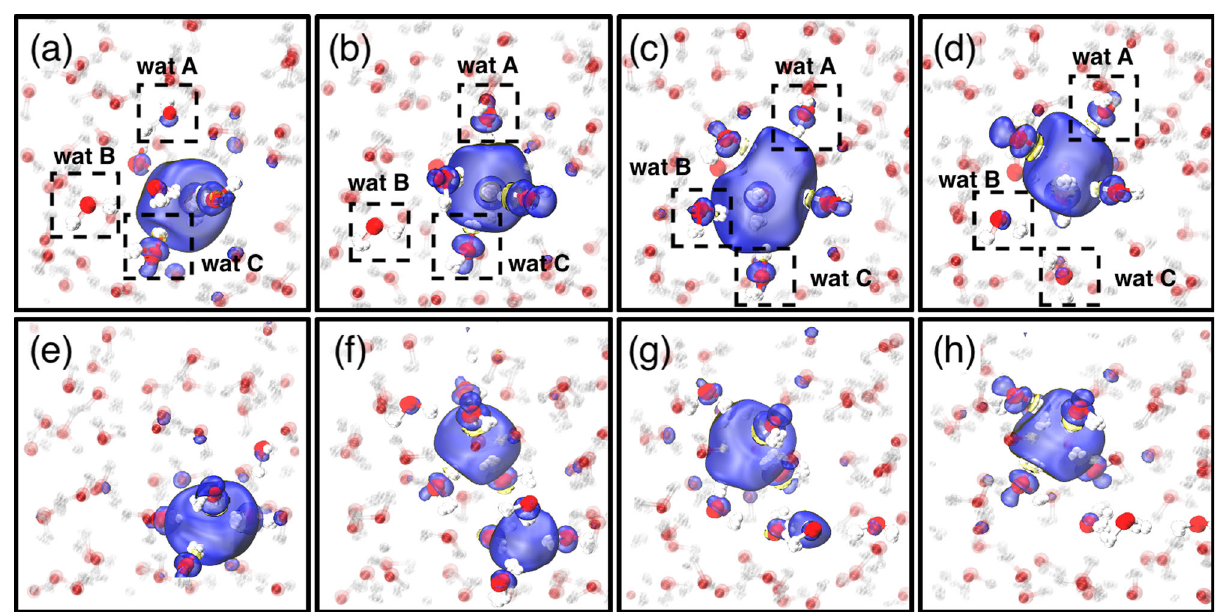
Fig. 2 Non-transient (top) and transient (bottom) diffusion mechanisms. Spin densities are shown in blue (positive) and yellow (negative). Non-transient mechanism is initiated by the formation of the hydrogen bonds (HBs) between a cavity-forming molecule and its unbonded neighboring water molecules (indicated as A and B in panels ( a ) – ( d )). The dangling OH of A, B subsequently binds to the hydrated electron in the cavity, replacing that of a third molecule, C (panel ( c )). Molecules B and C form HBs with their neighbors, and unbind from the cavity (panel ( d )). Transient diffusion (panels ( e ) to ( h )) is characterized by the existence of the double-cavity (panel ( f